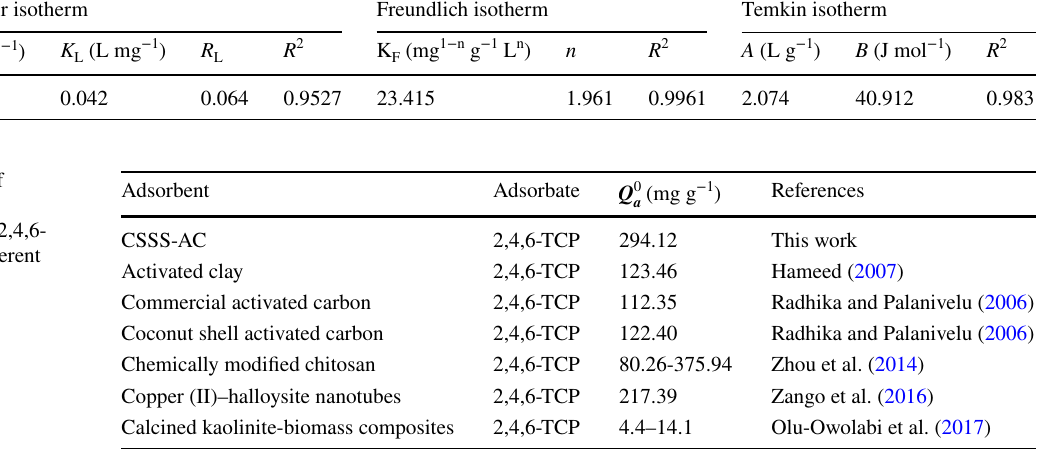
Table 7 Isotherm parameter constants for 2,4,6-TCP adsorption onto CSSS-AC at 30 °C Parameter